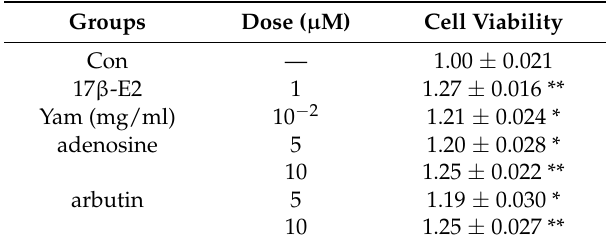
Table 3. The influence on MCF-7 cell proliferation (x ± SD, n = 4).